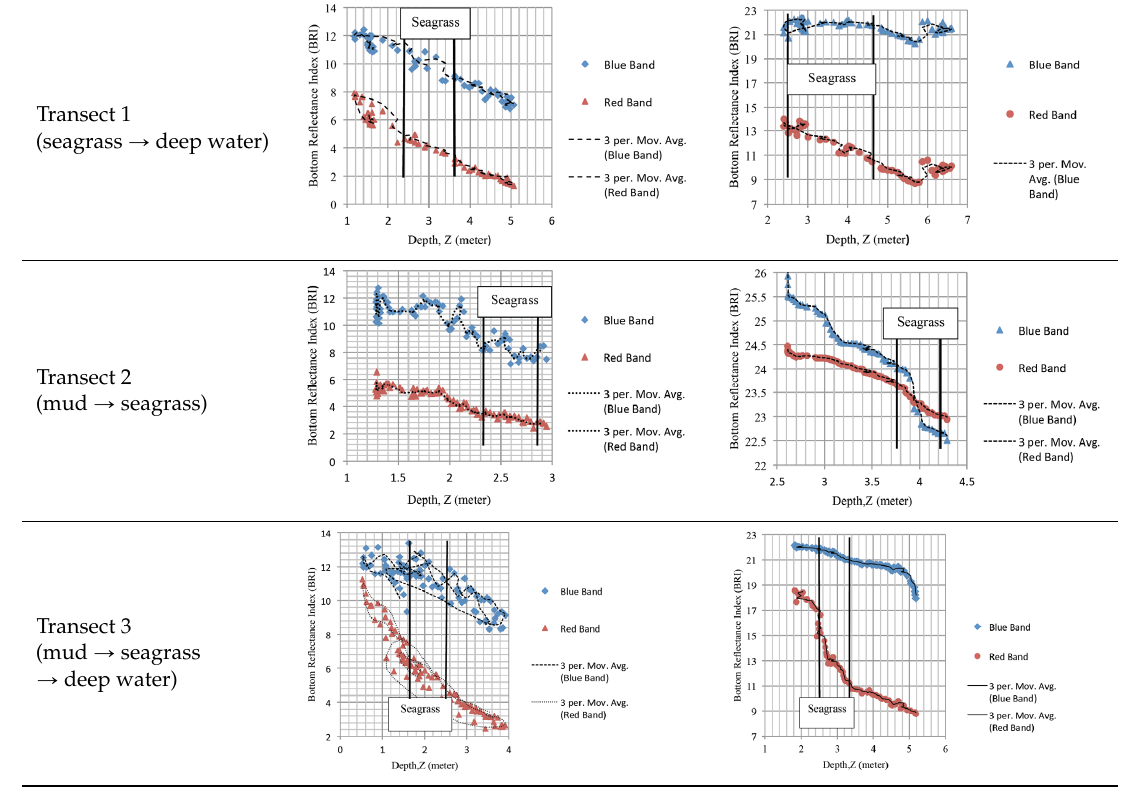
Figure 10. Relationship between BRI b and STAGB measured empirically from satellite image after water column correction for Landsat images acquired in 2009 and 2013. Table 10. BRI variation of two bands along few transects as shown in Figure 1 across the different sea bottom features. The left column is for Landsat 5 TM 2009 and the right column is for Landsat 8 OLI 2013.